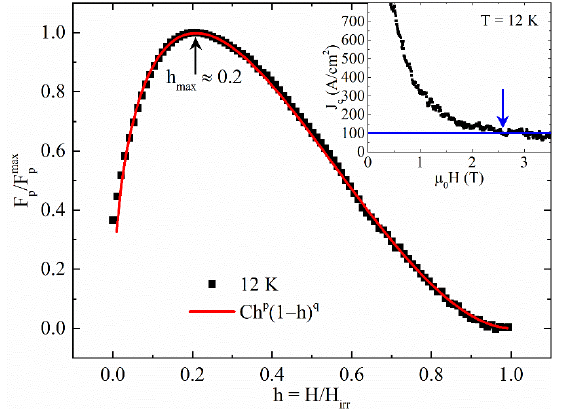
Figure 6. Normalized pinning force density ( F (cid:2926)(cid:2923)(cid:2911)(cid:2934) ≈ 3.9 × 10 6 N/m 3 ) as a function of the reduced magnetic field H/H irr at T = 12 K fitted with Equation (5) (red solid line). Inset: determination of H irr at T = 12 K ( μ 0 H irr = 2.6 T).